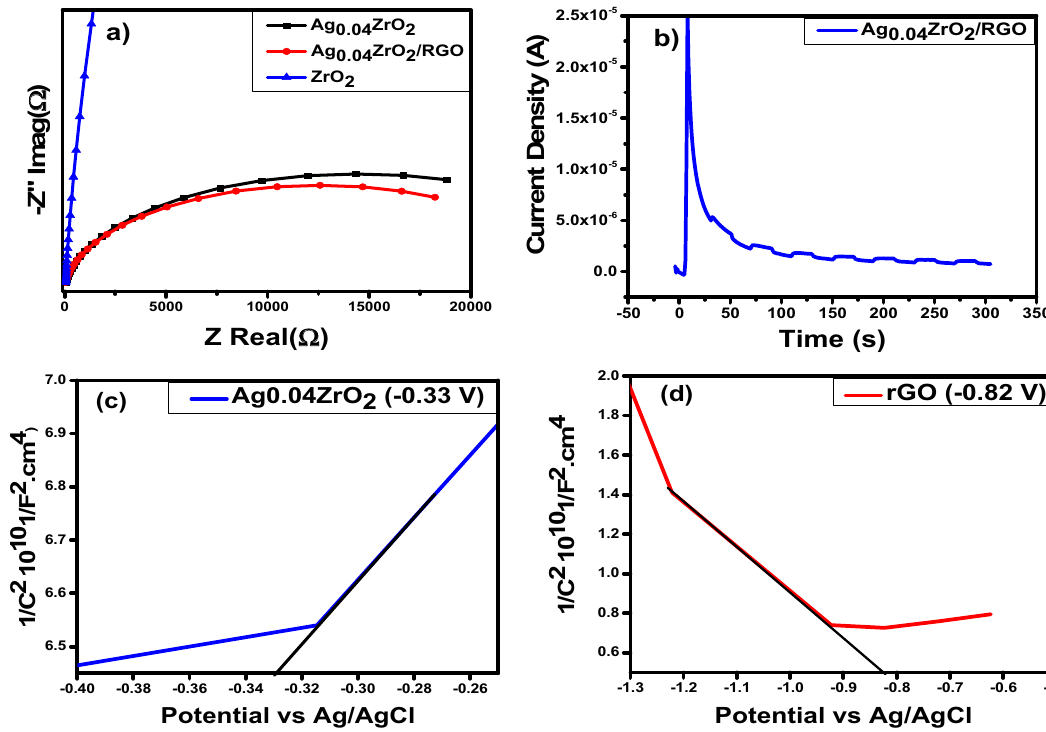
Figure 9. ( a ) Shows the EIS spectra of the prepared pure and heterostrucrure photocatalysts ( b ) shows chronoamperometric on/off study of the best Ag 0.04 ZrO 2 /rGO photocatalyst. ( c ) Mott-Schottky plots of Ag 0.04 ZrO 2 and ( d ) Mott-Schottky plots of rGO.